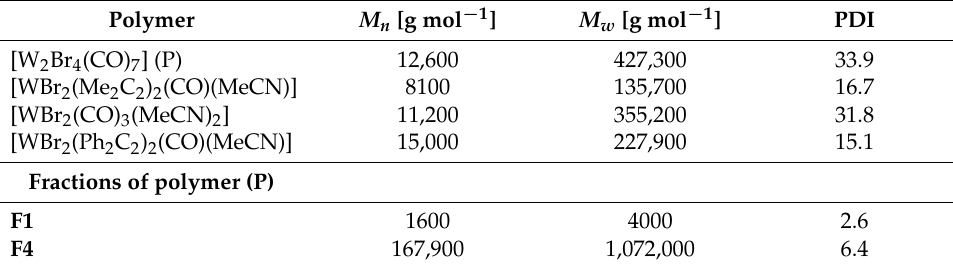
Table 1. Summary of number average molar mass ( M n ), weight average molar mass ( M w ) and polydispersity index (PDI) of the polymers synthesized with the four tungsten catalysts ( 1 )–( 4 ) ( top ) and of the two fractions F1 and F4 ( bottom ) from the fractionation of polymer P